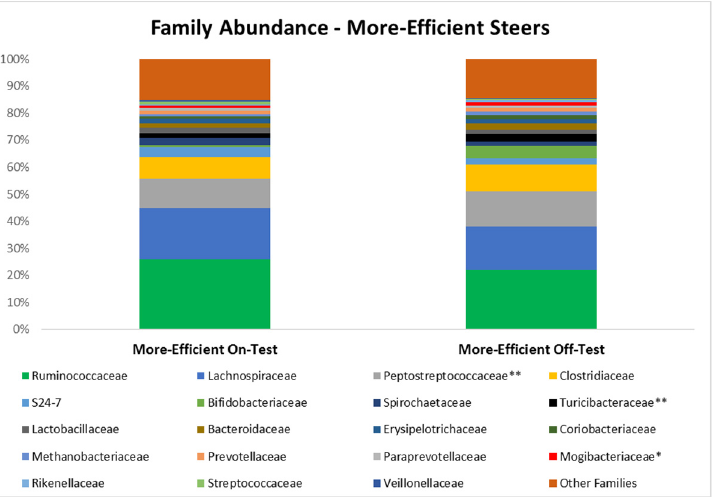
Figure 3. Relative abundance of the main families detected in the feces of the more efficient (Low RFI) steers at the beginning (on-test; d 0) and end (off-test; d 82) of the feedlot phase. * Indicates a trend (0.05 < p ≤ 0.10). ** Indicates a difference ( p ≤ 0.05) in abundance of the family.